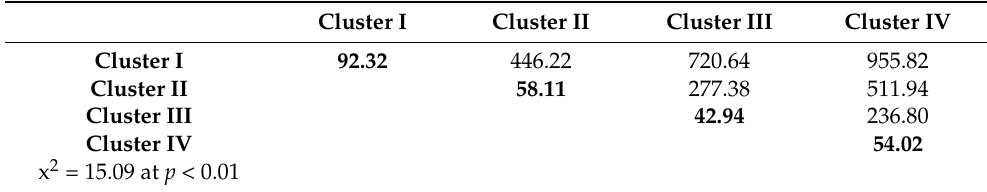
Table 4. Intra- (diagonal values) and inter-cluster divergence (off-diagonal values) in 262 genotypes from the Andean common bean diversity panel (ADP) evaluated under Al-toxicity treatment based on pairwise generalized squared distance.